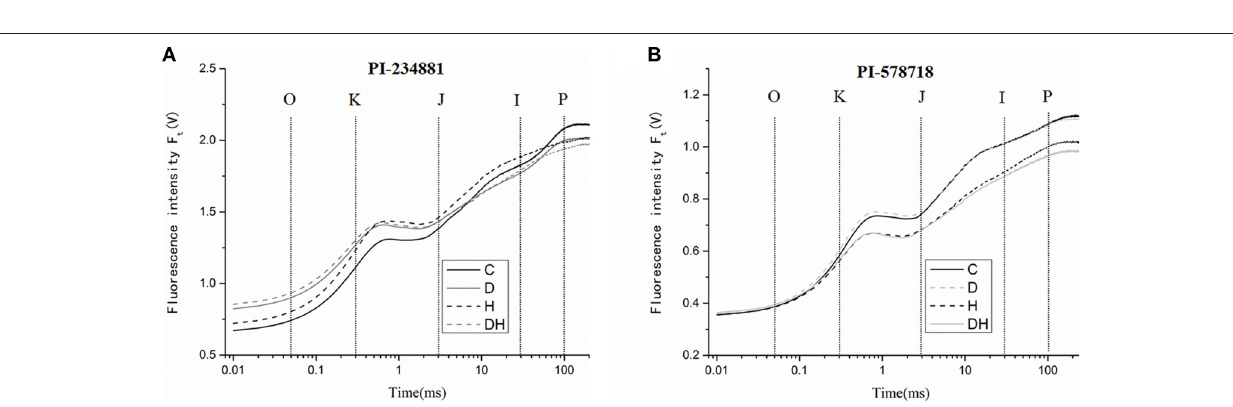
FIGURE 3 | The OJIP fluorescence transients in tall fescue leaves under control (C), drought (D), heat (H), combined stress (DH) in PI 234881 (A) and PI 578718 (B) accessions. Tall fescue leaves were vacuum-infiltrated for 15 min in the dark.